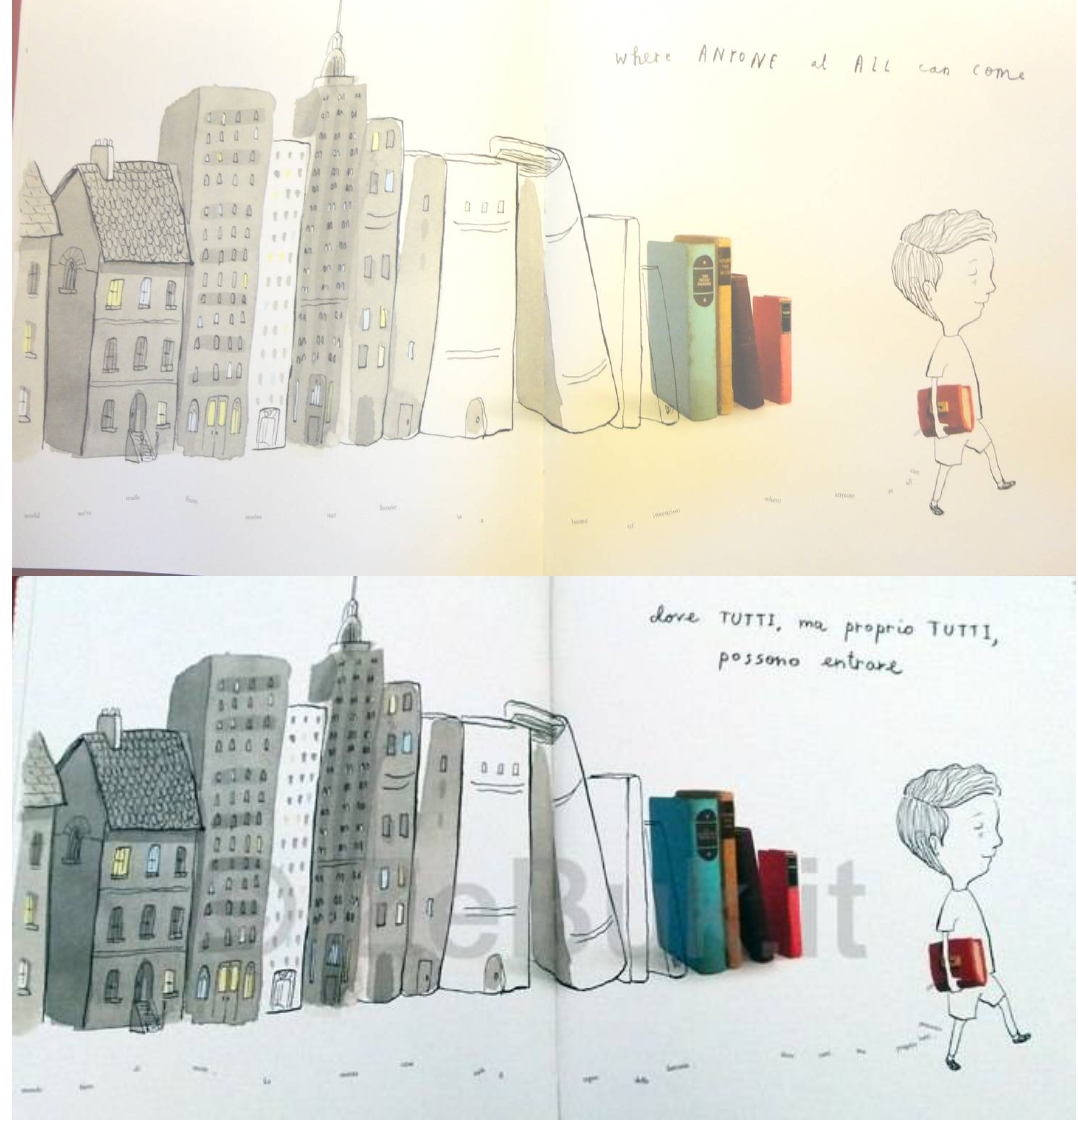
Figure A21. Jeffers O.; Winston S. A child of books, Walker Books, London, 2016; Jeffers O.; Winston S. La bambina dei libri, Lapis, Roma,